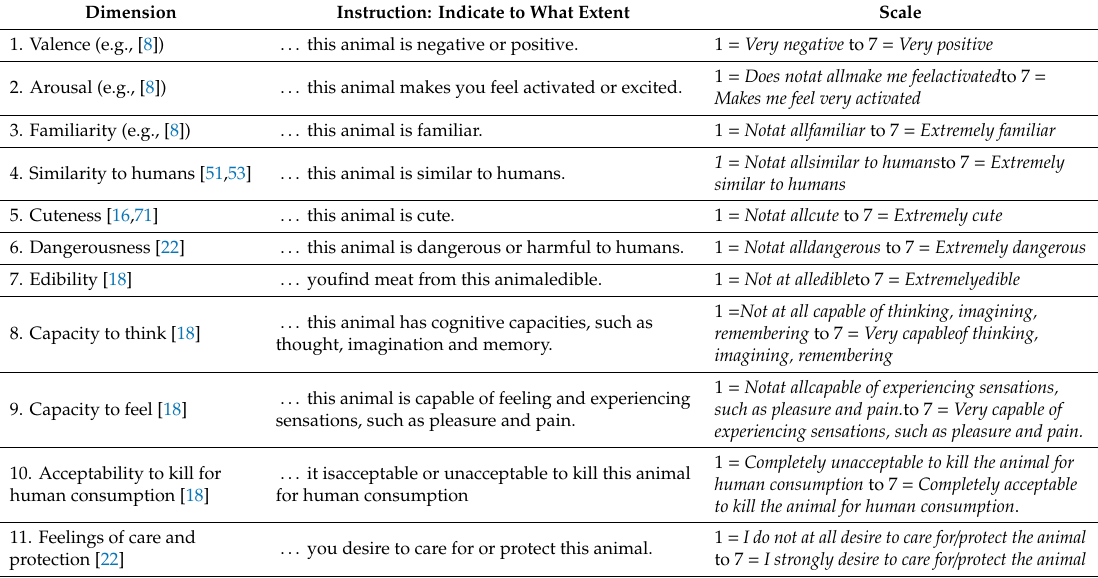
Table 1. Instructions and scale anchors for each evaluative